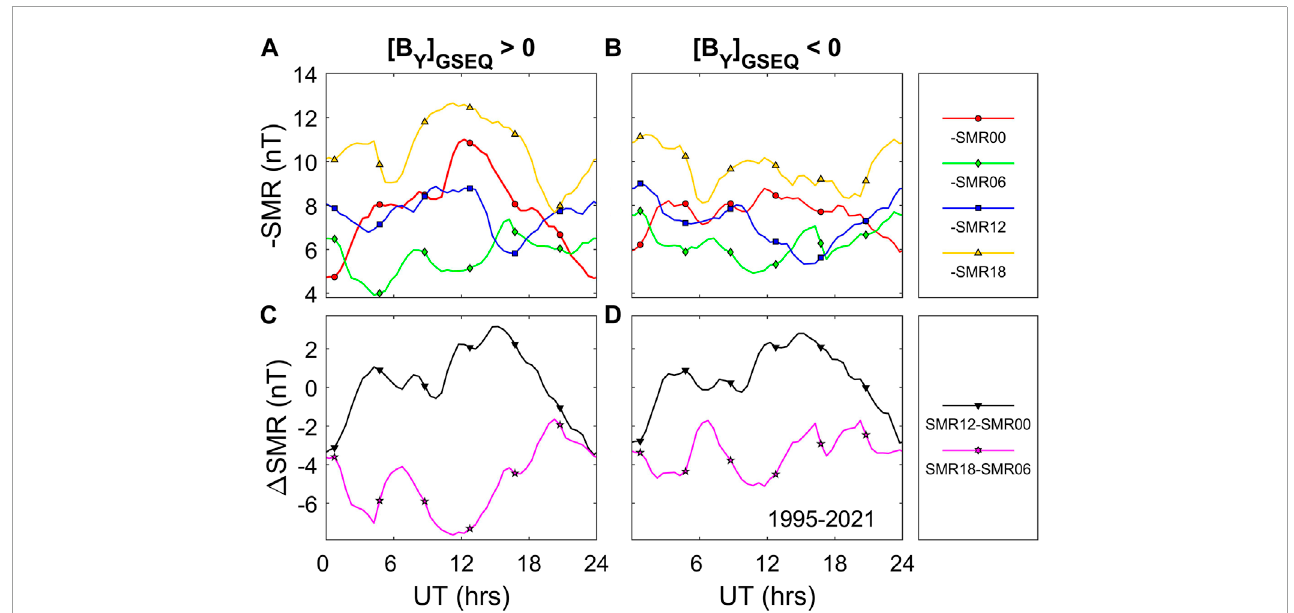
FIGURE 18 UT variations of the SuperMAG partial ring current indices, described by Newell and Gjerloev (2012). The top panels show -SMR00 (around midnight, in red with circle symbols); -SMR06 (around dawn, in green, with diamond symbols); -SMR12 (around noon, in blue with square symbols), and -SMR18 (around dusk, in orange with triangle symbols). The lower panels show the difference between the noon and midnight indices ( SMR12-SMR00 , in black with inverted triangle symbols) and between dawn and dusk indices ( SMR18-SMR06 , in mauve with star symbols). The left-hand column is for [ B Y ] GSEQ > 0, and the right-hand column for [ B Y ] GSEQ < 0. Data are for 1980–2021,